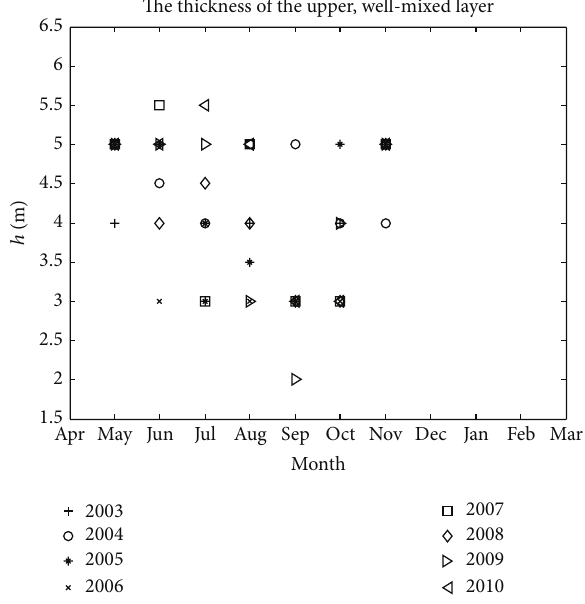
Figure 3: Monthly-mean thickness value of the upper well-mixed layer from 2003 to